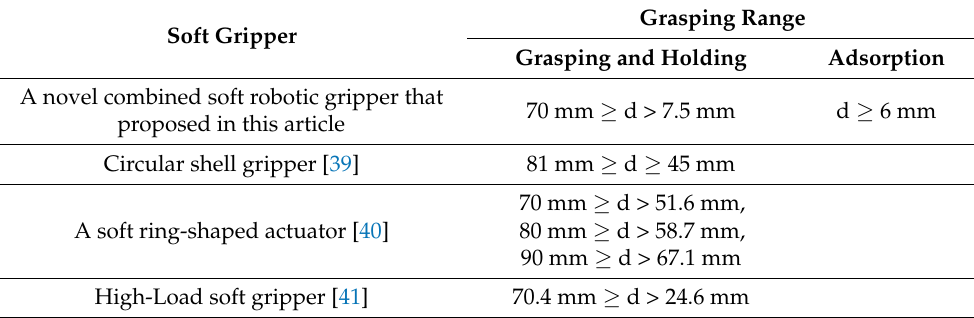
Table 2. Comparison of the grasping range of soft grippers. Soft Gripper